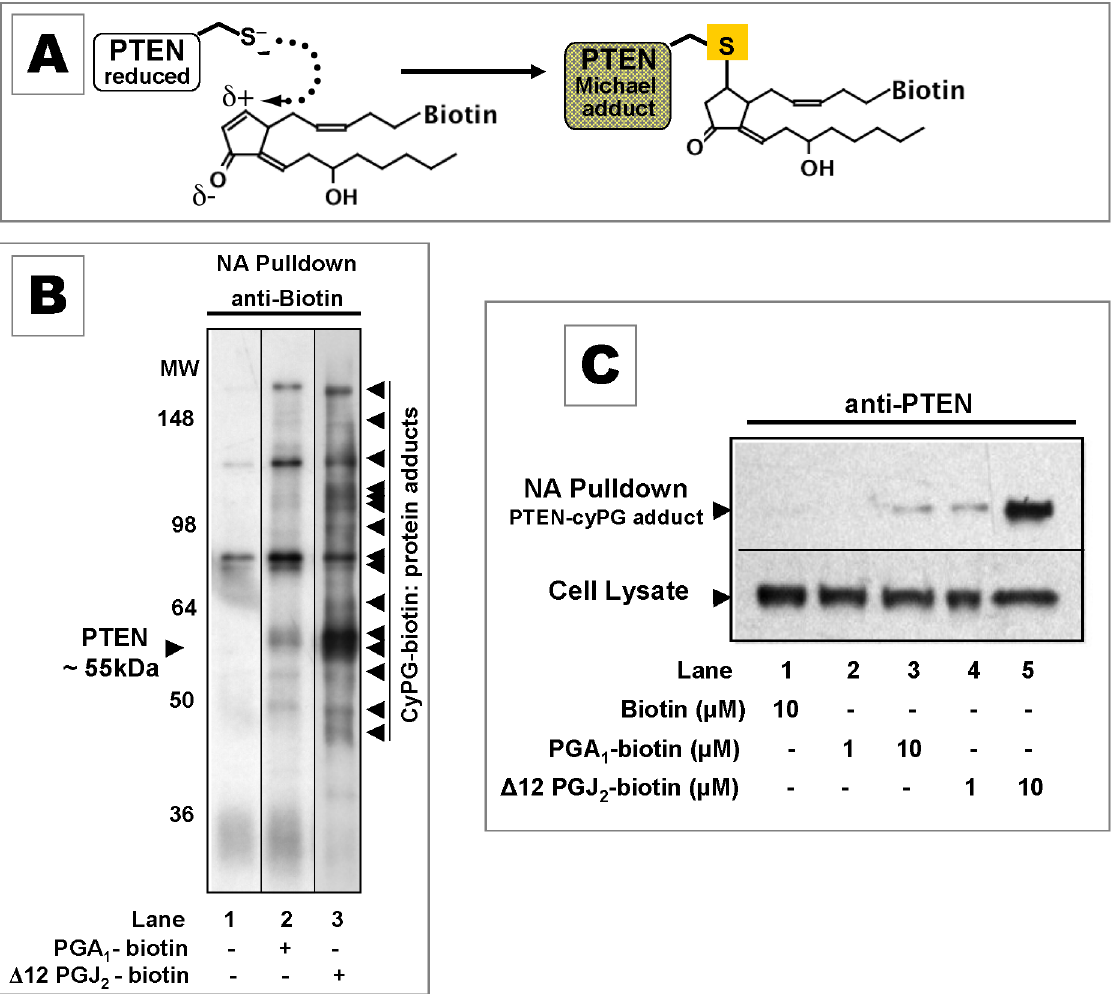
Figure 2. CyPG biotin analogs: model a , ß–unsaturated carbonyls alkylate cellular PTEN. ( A ) Michael addition reaction between PTEN and a D 12-PGJ 2 -biotin analog. Following treatment of cells with cyPG-biotin, proteins with a de novo biotin epitope were sequestered onto neutravidin beads (NA Pulldown), then fractionated by SDS-PAGE for immunoblotting. ( B ) Anti-biotin immunoblot of proteins from lysates of MCF-7 cells treated with DMSO (lane 1), 10 m M PGA 1 -biotin (lane 2), and 10 m M D 12PGJ 2 -biotin (lane 3). D 12-PGJ 2 biotin formed a covalent adduct with proteins more readily than PGA 1 -biotin (arrowheads). ( C ) Anti-PTEN immunoblot of cellular PTEN that formed a covalent adduct with cyPG-biotin (NA Pulldown) relative to total PTEN (Cell Lysate) from MCF-7 cells treated with DMSO (lane 1), 1 or 10 m M PGA 1 -biotin (lanes 2, 3), and 1 or 10 m M PGJ 2 -biotin (lanes 4, 5). Blots are representative of results obtained in at least three independent experiments.